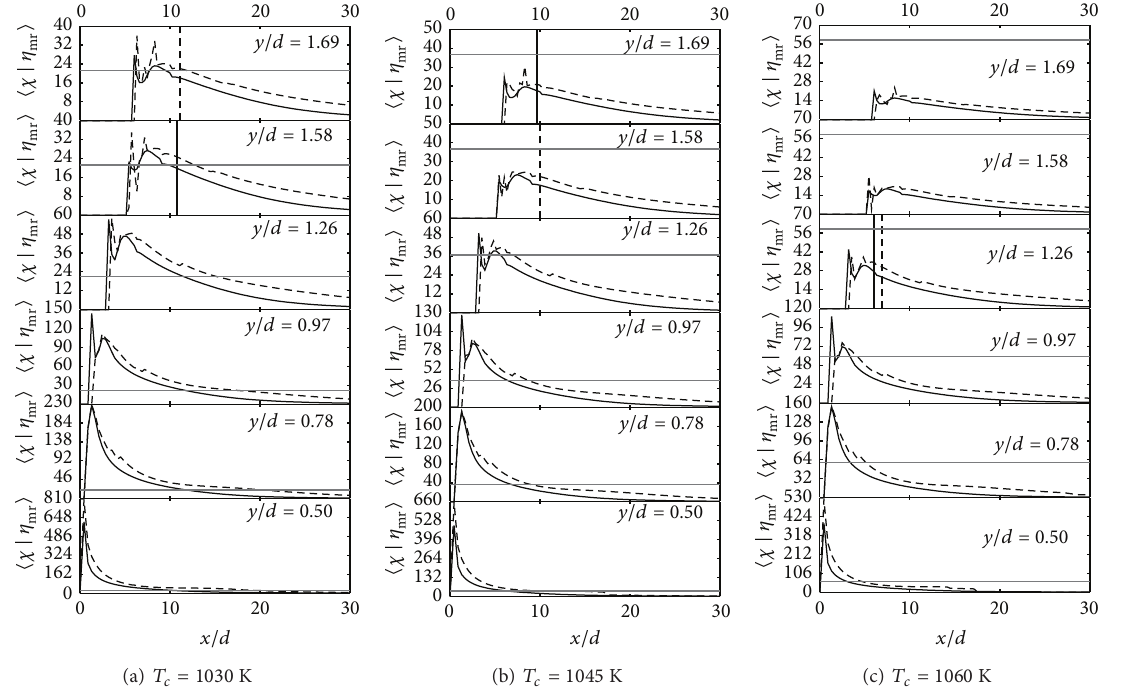
⟩ at several radial locations. (a) 𝑇 mr